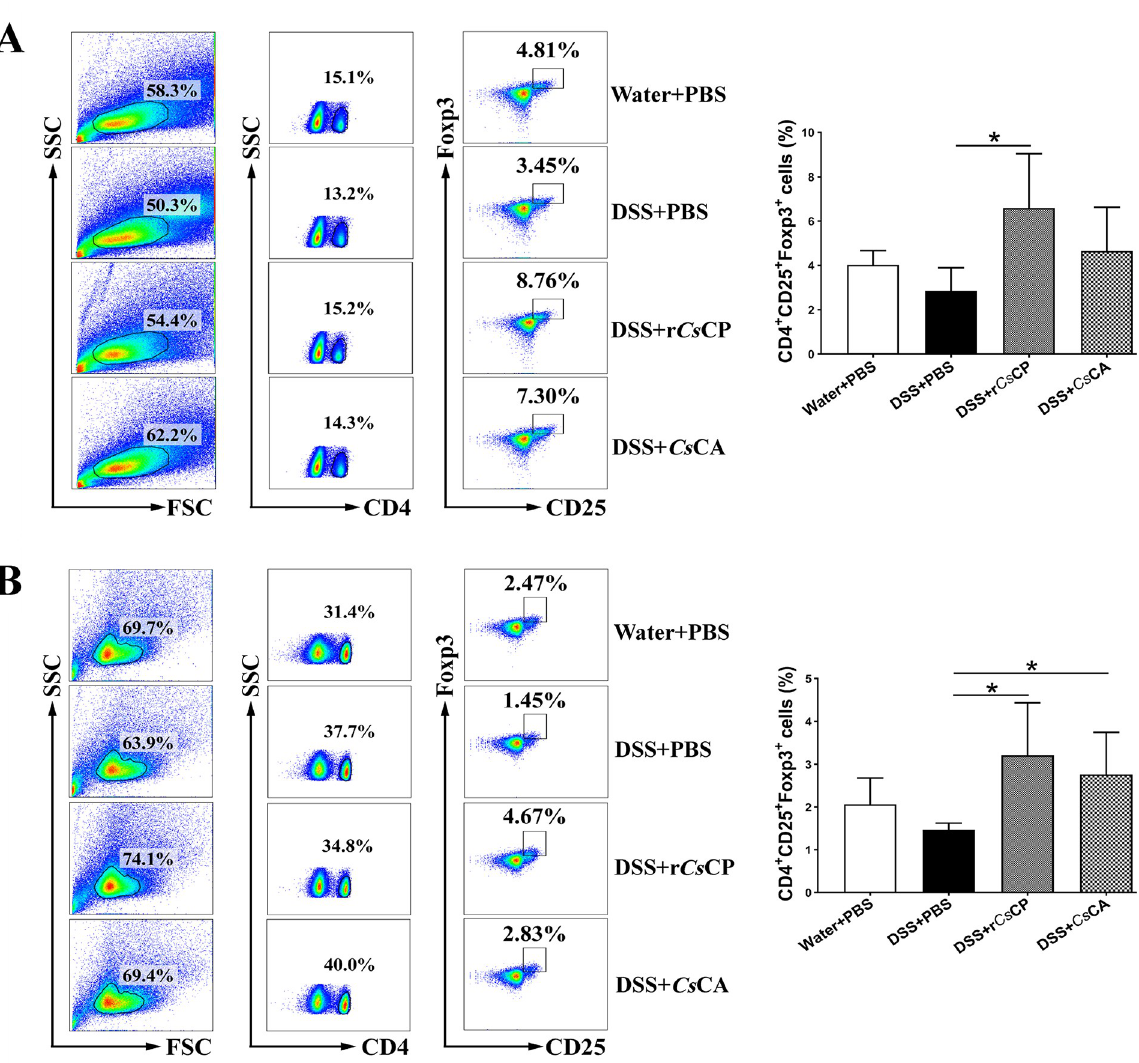
Fig 4. Proportion of CD4 + CD25 + Treg cell subsets in mice spleens and MLNs. To detect Tregs, spleens and MLNs were isolated to prepare single cell suspensions for CD4, CD25 and Foxp3 mAbs staining and flow cytometry analysis. (A) Frequency of Treg cells in splenocytes. (B) Frequency of Treg cells in mesenteric lymphocytes. Data are shown as mean ± SEM (n = 4). � P < 0.05.